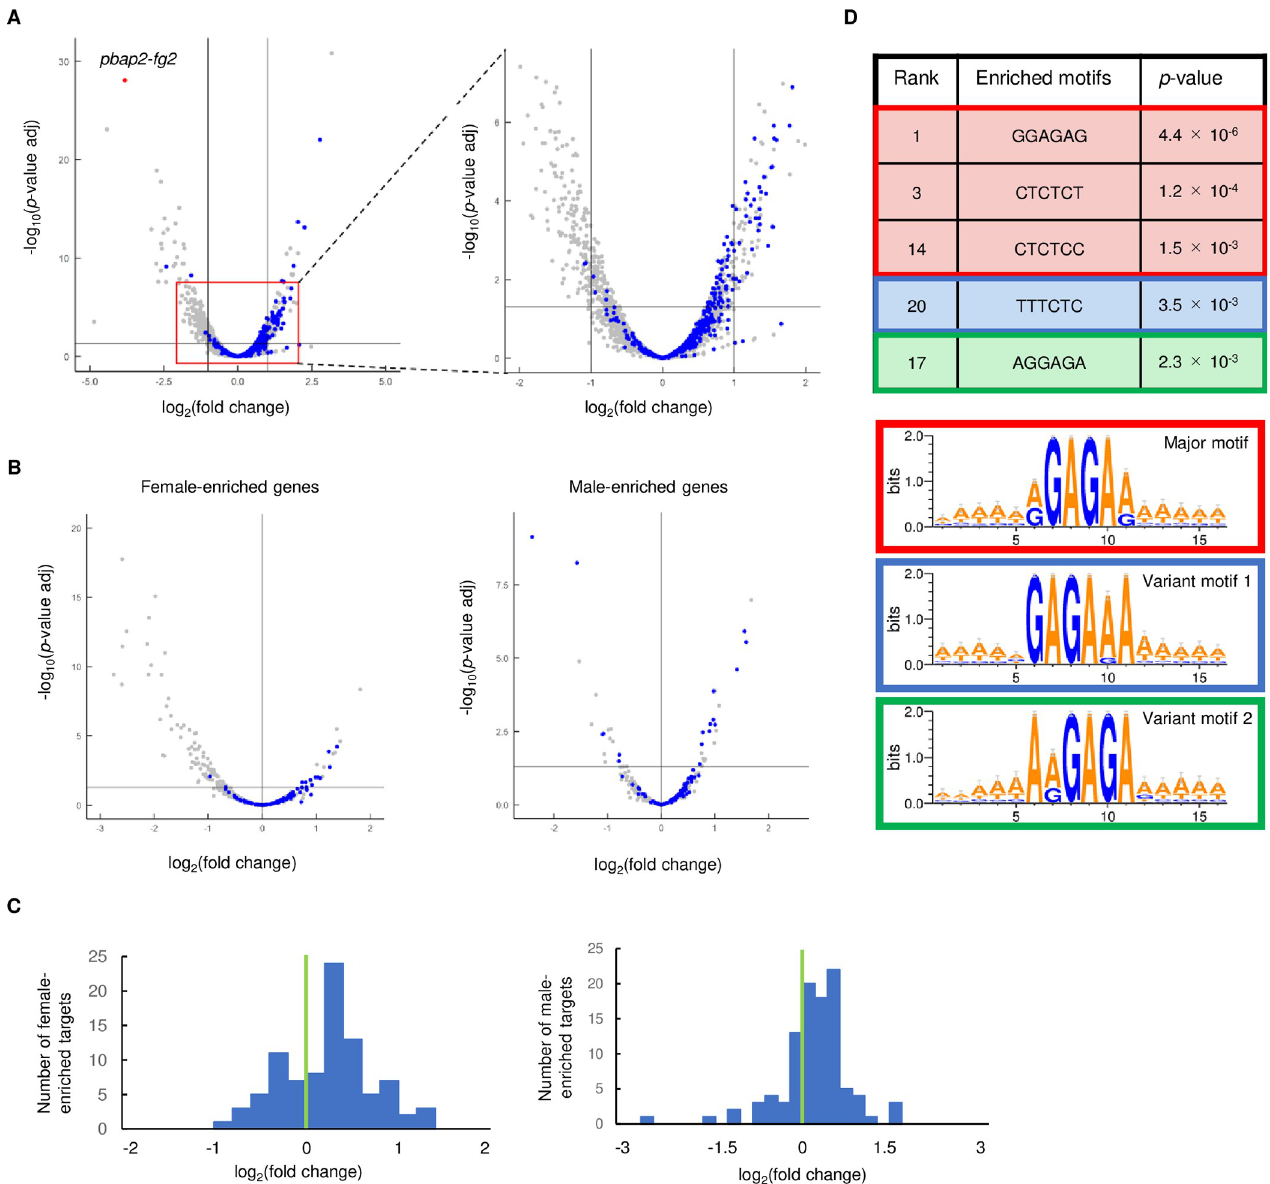
Fig 4. Relationship between target genes of Pb AP2-FG2 and DEGs in pbap2-fg2 (-). (A) A volcano plot showing DEGs in pbap2-fg2 (-) compared to WT. Blue dots represent the target genes of Pb AP2-FG2, and a red dot indicates pbap2-fg2 . A horizontal line indicates p -value of 0.05, and two vertical lines indicate log 2 (Fold Change) of -1 and 1. All genes with RPKM � 10 are depicted in the left panel. For the right panel, region from log 2 (Fold Change) of -2 to 2 and from -log 10 ( p -value) of 0 to 7.5 is magnified. (B) Volcano plots showing DEGs in pbap2-fg2 (-) for female and male-enriched genes (the left and right panel, respectively). Blue dots represent the target genes of Pb AP2-FG2. A horizontal line indicates a p -value of 0.05, and a vertical line indicates log 2 (Fold Change) of 0. (C) Distribution of log 2 (Fold Change) values for female and male-enriched target genes of Pb AP2-FG2 (the left and right graph, respectively). A green line indicates log 2 (Fold Change) of 0. (D) Six-bp DNA motifs enriched within the upstream region (300 to 1200 bp from ATG) of genes upregulated in pbap2-fg2 (-). The major and variant motifs are each indicated in different color boxes. The ranks were assigned to all enriched motifs according to their p